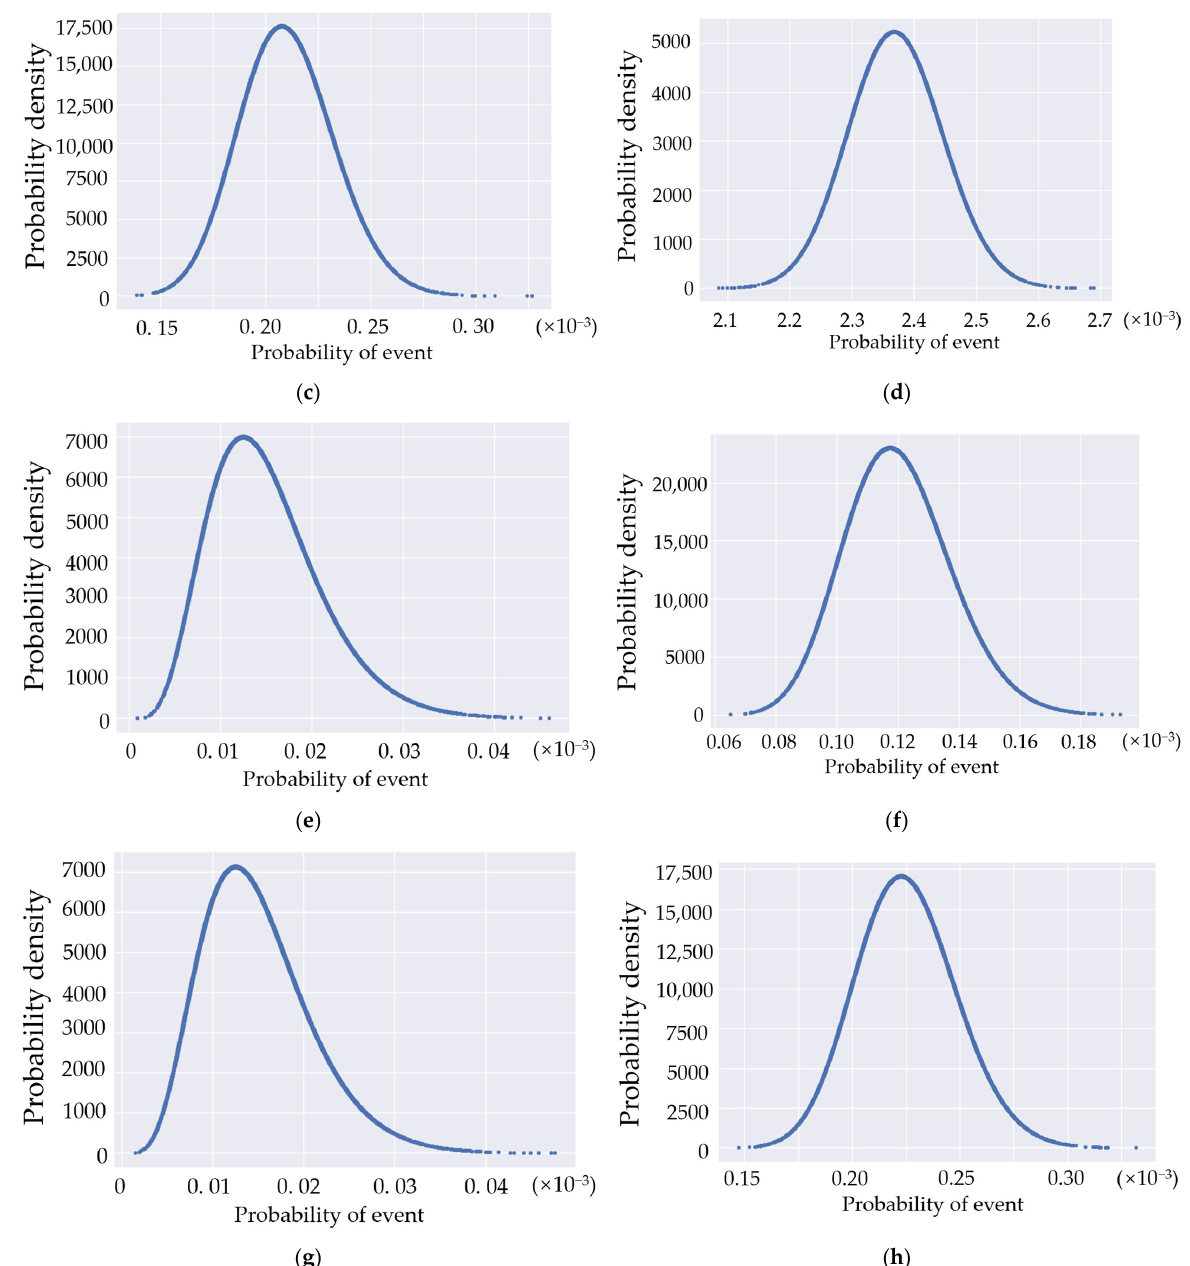
Figure 16. Risk coefficient distributions of elementary events. ( a ) Insufficient bonding strength of finishing layer. ( b ) Detail insufficiency of glass fiber mesh. ( c ) Insufficient thickness of crack resistant mortar. ( d ) Swelling defect of finishing layer. ( e ) Insufficient number of anchor bolts. ( f ) Insufficient bonding strength of thermal insulation coat. ( g ) Insufficient bonding area of thermal insulation coat. ( h ) Swelling defect of thermal insulation coat. (3) Weight coefficients calculated by